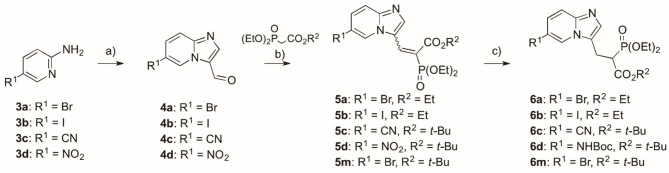
Reagents and conditions: (a) bromomanoloaldehyde, microwave irradiation, 10 min, 110°C, yield 54–80% (Kusy et al., 2019); (b) tert-butyl diethylphosphonoacetate or triethyl phosphonoacetate, TiCl4, TEA, DCM, overnight, rt, yield 42–66%; (c) for compounds 6a–c, m: NaBH4, NiCl2·6H2O, MeOH, −40°C, yield 74–87%; for compound 6d: (I) 5d, H2, Pd/C, 24 h, rt, (II) Boc2O, DCM, 24 h, rt, (III) NaBH4, NiCl2·6H2O, MeOH, −40°C, yield (three steps) 48%.